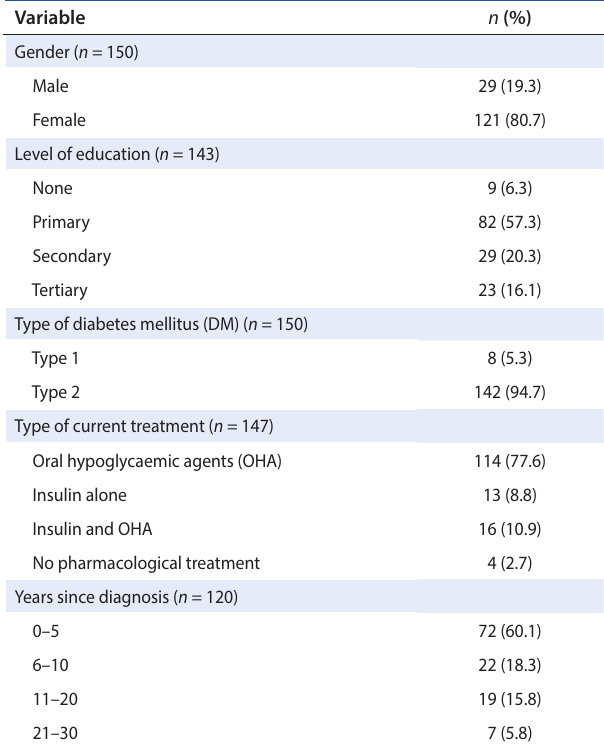
Table 1: Socio-demographic and disease characteristics